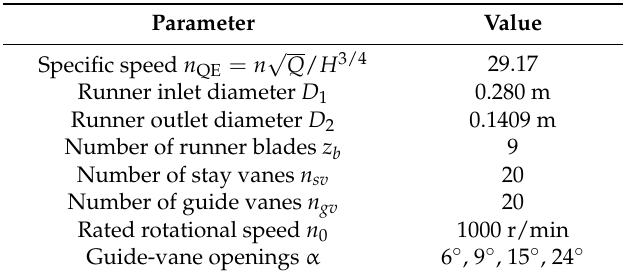
Table 1. Parameters of the model pump-turbine.